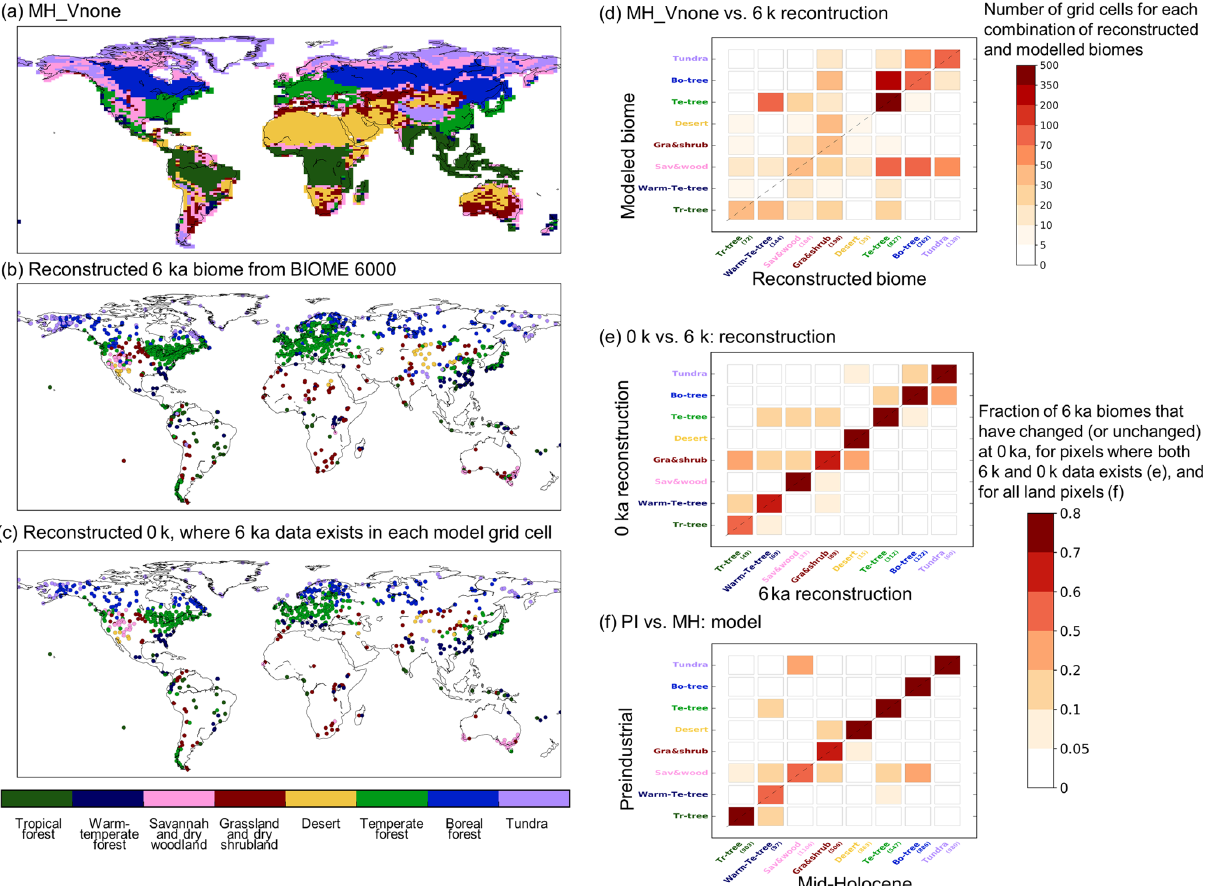
Figure 14. (a) Simulated mega-biome distribution by MH-Vnone, converted from the modeled PFT properties using the default algorithm described in Fig. A1. Panels (b) and (c) : reconstructions in BIOME 6000 DB version 1 for the MH and PI periods (Harrison, 2017). (d) Number of pixels where reconstruction is available and the model matches (or does not match) the data. Note that multiple reconstruction sites may be located in the same model grid cell, in which case we did not group them so that each site was counted once. Numbers in parentheses on the x axis in (d) represent the number of sites for each biome type. Panel (e) same as (c) but for the number of matches between (e) the BIOME6000 MH (6k) and PI (0k) reconstructions at pollen sites and (f) the simulated mega-biomes for MH and PI at each model grid